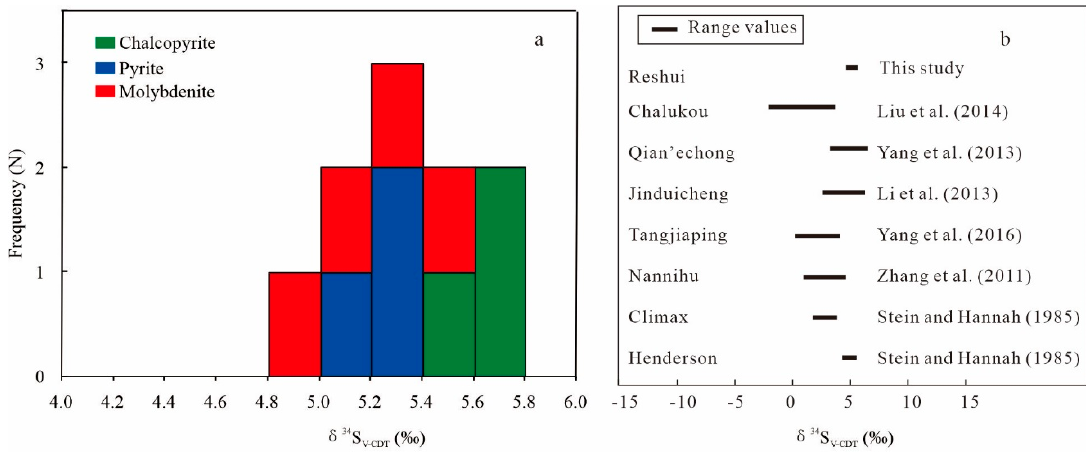
Figure 10. Histogram of sulfur isotopic compositions from the Reshui Mo deposit. Data sources: data of the Chalukou deposits in the Tianshan-Xingmeng orogenic belt are from Liu et al. [61]; data of the Qian’echong, Jinduicheng, Tangjiaping, and Nannihu deposits in the Qinling–Dabie Mo belt are from Yang et al. [74]; Li et al. [98] and Zhang et al. [44]; data of the Climax and Henderson deposits in western America are from Stein et al. [99]. ( a ) Histograms of δ 34 S values in the Reshui Mo deposit; ( b ) Comparison of the Reshui Mo deposit with other porphyry Mo deposits.